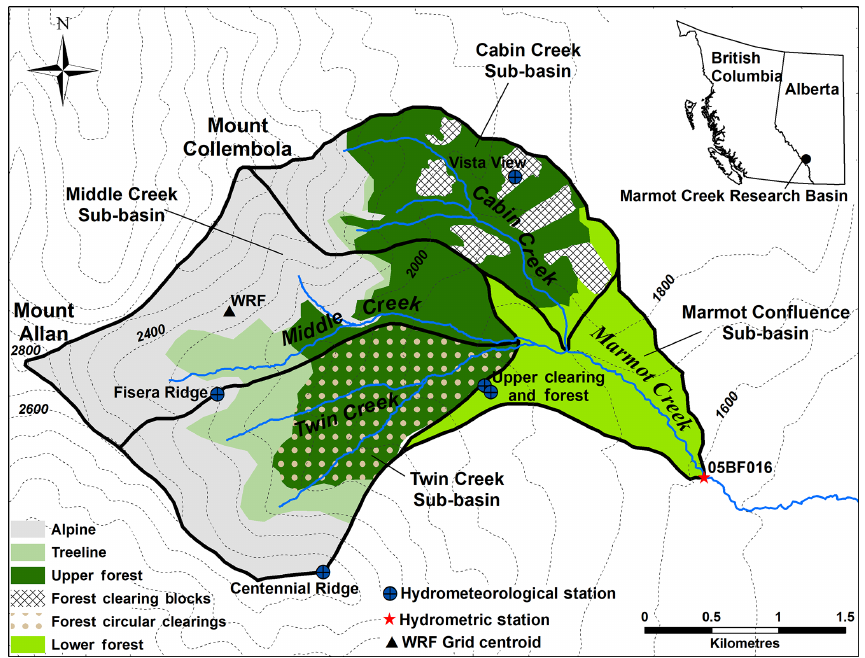
Figure 1. Location and contour map of the Marmot Creek Research Basin (MCRB), showing hydrometeorological stations, a hydrometric station, a WRF grid centroid, and ecozones of the MCRB: alpine, treeline, upper forest, forest clearing blocks, forest circular clearings, and lower forest. Note that the WRF grid centroid represents the centre of the 4km WRF grid, and the sizes and areas of circular clearings in Twin Creek are meant to represent a honeycomb pattern and are not to